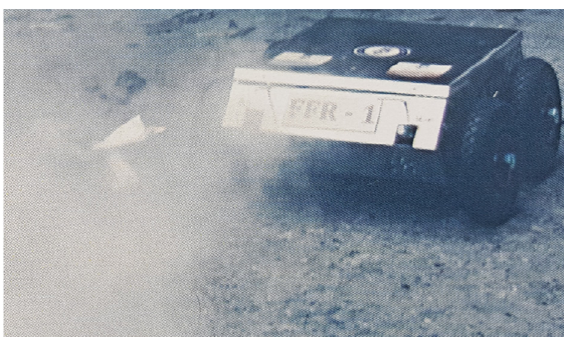
Figure 6. Unmanned ground vehicle (UGV) performing fire extinguishing testing, carried out at the Military Technical Academy yard on 26 October 2017, at the Patriot Fest contest.